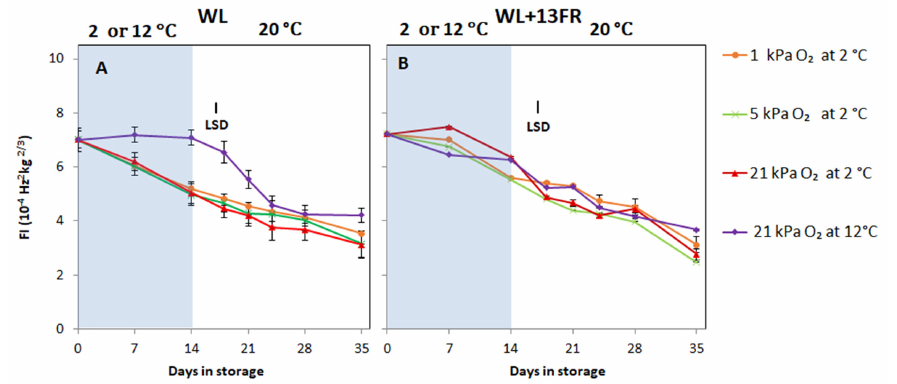
Figure 6. Firmness as indicated by firmness index (FI) of MG tomatoes cultivated under white LED light (WL) without far red lighting ( A ) or with far red lighting during cultivation ( B ) during cold storage (blue area) at 2 or 12 ◦ C and subsequent shelf-life at 20 ◦ C (white area). Orange, green, red and purple lines and symbols indicate 1, 5 and 21 kPa O 2 (low oxygen control) applied during storage at 2 ◦ C, and 21 kPa O 2 at 12 ◦ C (temperature control), respectively. The average firmness index with indicated standard error is shown for two replicates of four tomatoes ( n = 2); (repeated measure over times). LSD values ( p < 0.05) are indicated per panel.